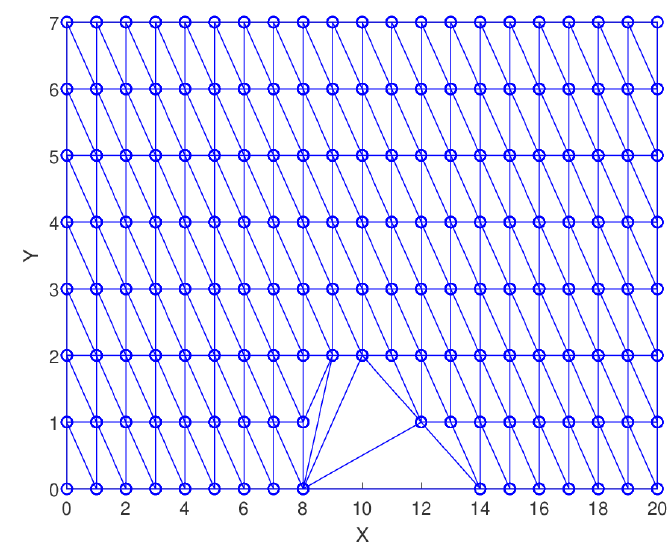
Figure 31. Delaunay triangulation for digital elevation data.